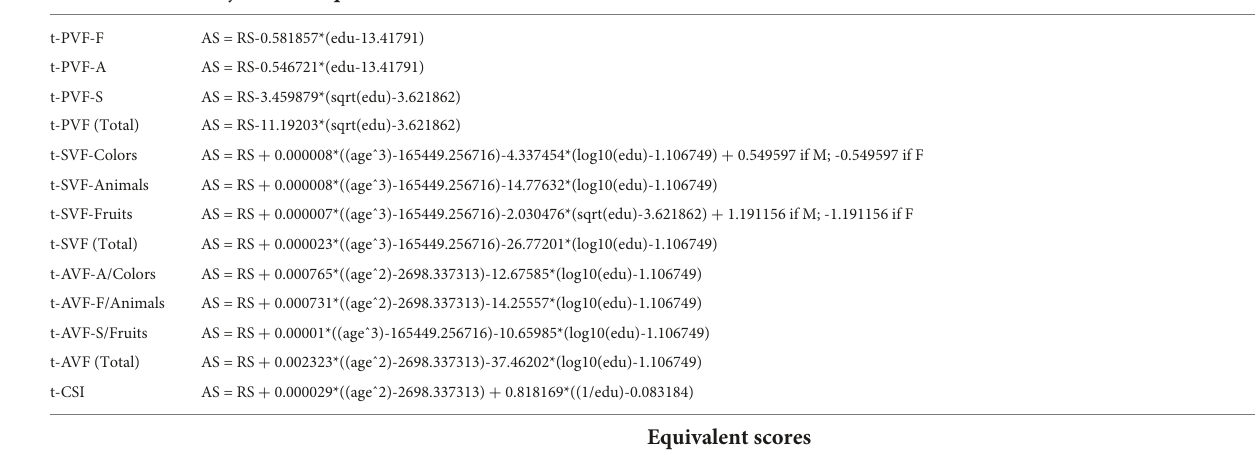
TABLE 3 Adjustment equations and Equivalent Scores of the telephone-based Verbal Fluency Battery (t-VFB). Measure Adjustment